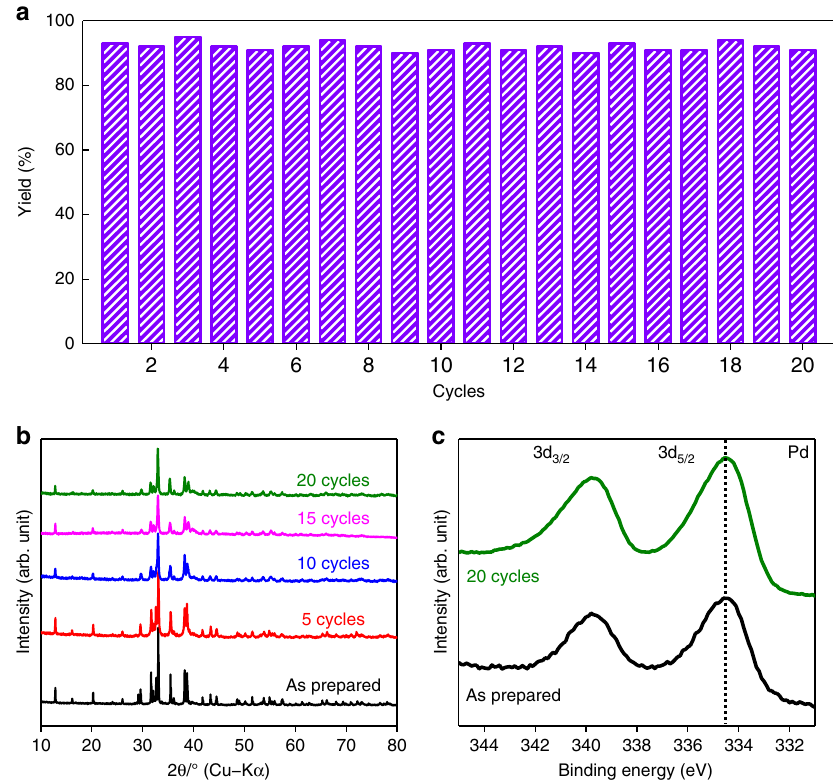
Fig. 5 Reusability of Y 3 Pd 2 . a Recycling experiment for the Suzuki cross-coupling reaction over Y 3 Pd 2 . Reaction conditions: Pd (40 mol% relative to organohalide); 0.5 mmol iodide, 0.8 mmol phenylboronic acid, 1.5 mmol K 2 CO 3 , 5 ml solvent, 30 °C. b Powder XRD patterns for as-prepared and used (after 5, 10, 15, and 20 cycles) Y 3 Pd 2 catalyst. c XPS Pd 3 d spectra for the as-prepared and used (after 20 cycles) Y 3 Pd 2